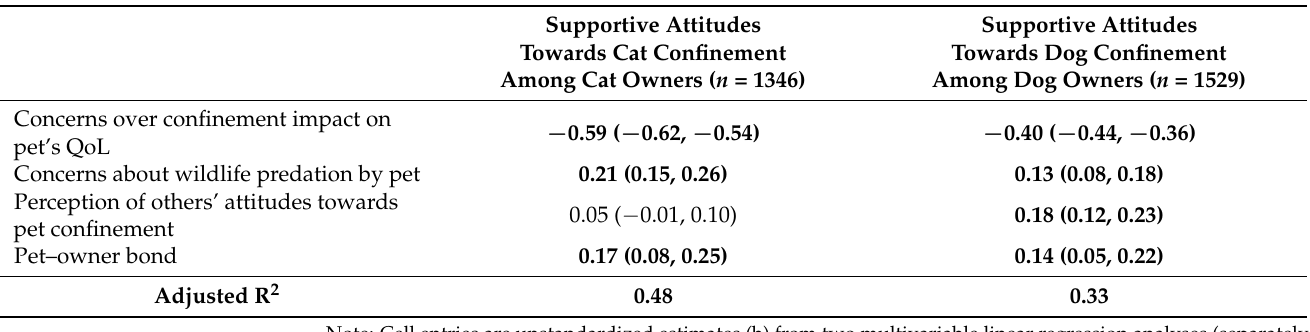
Table 5. Prediction of supportive attitudes towards cat and dog confinement by pet owners’ con- cerns abo ut wildlife and pets’ QoL, perception of others’ attitudes and pet– owner bond, separately for dogs and cats.